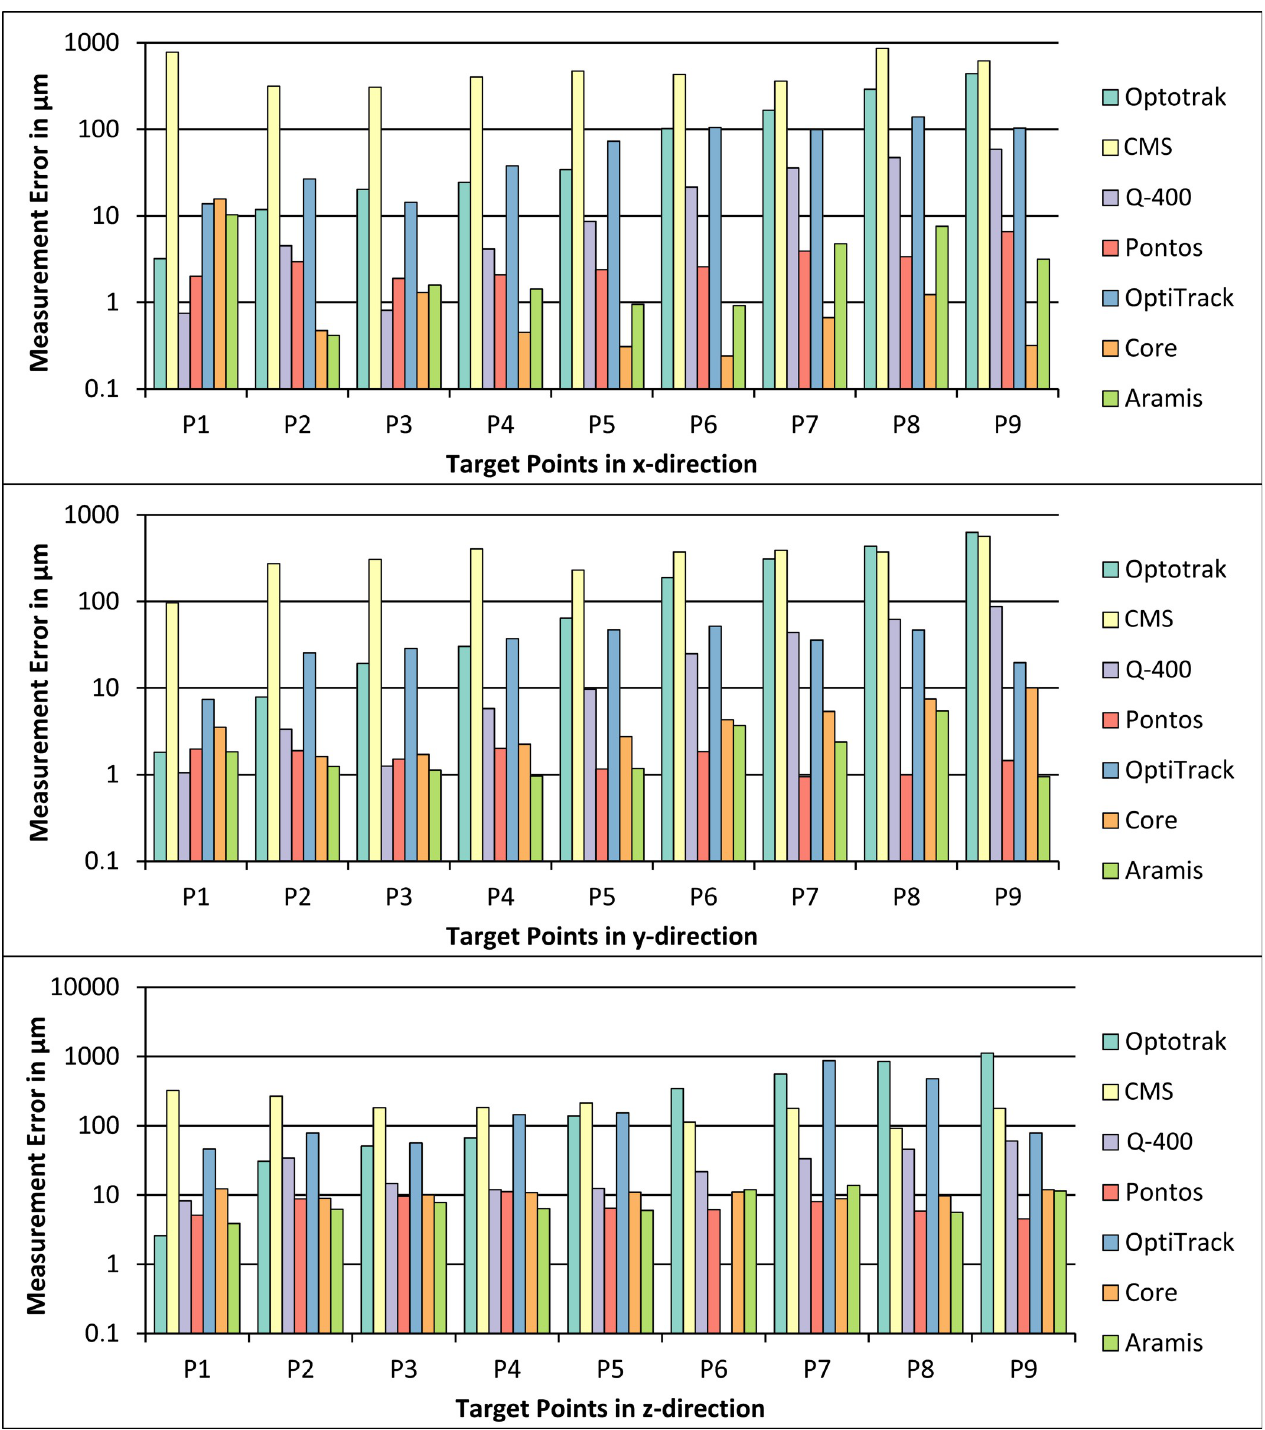
Fig 5. Measurement errors of the accuracy measurements of translational motions in x-direction (top diagram), y-direction (middle diagram) and z-direction (bottom diagram) for the seven measurement systems using the CMM as reference device.